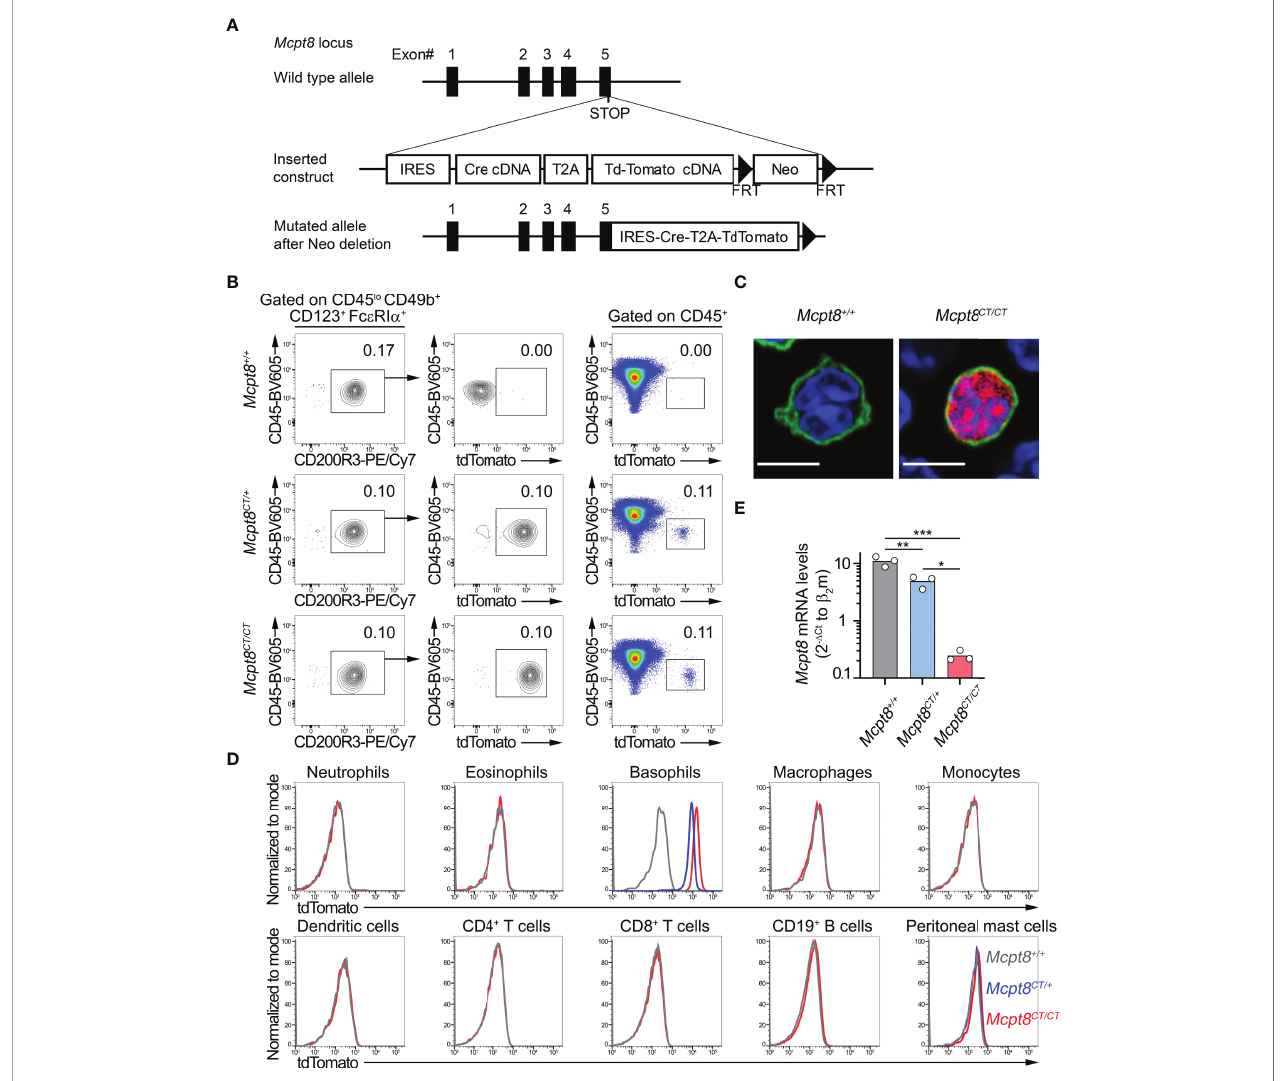
FIGURE 1 | The CT-M8 mice: a new basophil-speci fi c mouse model. (A) Schematic representation of Mcpt8-Cre-tdT knock-in targeting constructs to generate the CT-M8 ( Mcpt8 tm1Ics ) mice (see Methods ) where Cre and tandem tomato fl uorescent protein are expressed under the control of the basophil-speci fi c Mcpt8 promoter. (B) Fluorescence-activated cell sorter (FACS) gating strategy showing tdTomato expression in spleen basophils from Mcpt8 CT/CT and Mcpt8 CT/+ mice but not in wild-type animals ( Mcpt8 +/+ ). (C) Basophil-speci fi c tdTomato expression (red) imaged by confocal microscopy on splenocytes from Mcpt8 +/+ (left) and Mcpt8 CT/CT (right) mice, stained with anti-IgE antibody (green) and DNA staining (DAPI, blue). Scale bar, 5 µm. Larger fi elds are shown in Supplementary Figure S1 . (D) Expression of the tdTomato assessed by fl ow cytometry in the indicated spleen cell types (except for peritoneal mast cells, which are from the peritoneal cavity) de fi ned as described in Table 1 in Mcpt8 +/+ (grey lines), Mcpt8 CT/+ (blue lines), and Mcpt8 CT/CT (red lines). One representative set of data out of 4 per genotype is shown. (E) Mcpt8 mRNA expression levels were assessed by RT-quantitative PCR on mRNA puri fi ed from FACS-sorted bone marrow primary basophils from mice of the indicated genotypes (see Methods ). Data are expressed as the mean of the 2 − D Ct values of Mcpt8 relative to the b 2 -microglobulin Ct. Individual values are shown inside bars. Statistical analyses were done by one-way ANOVA followed by Tukey ’ s multiple comparisons test. * p < 0.05; ** p < 0.01; *** p <